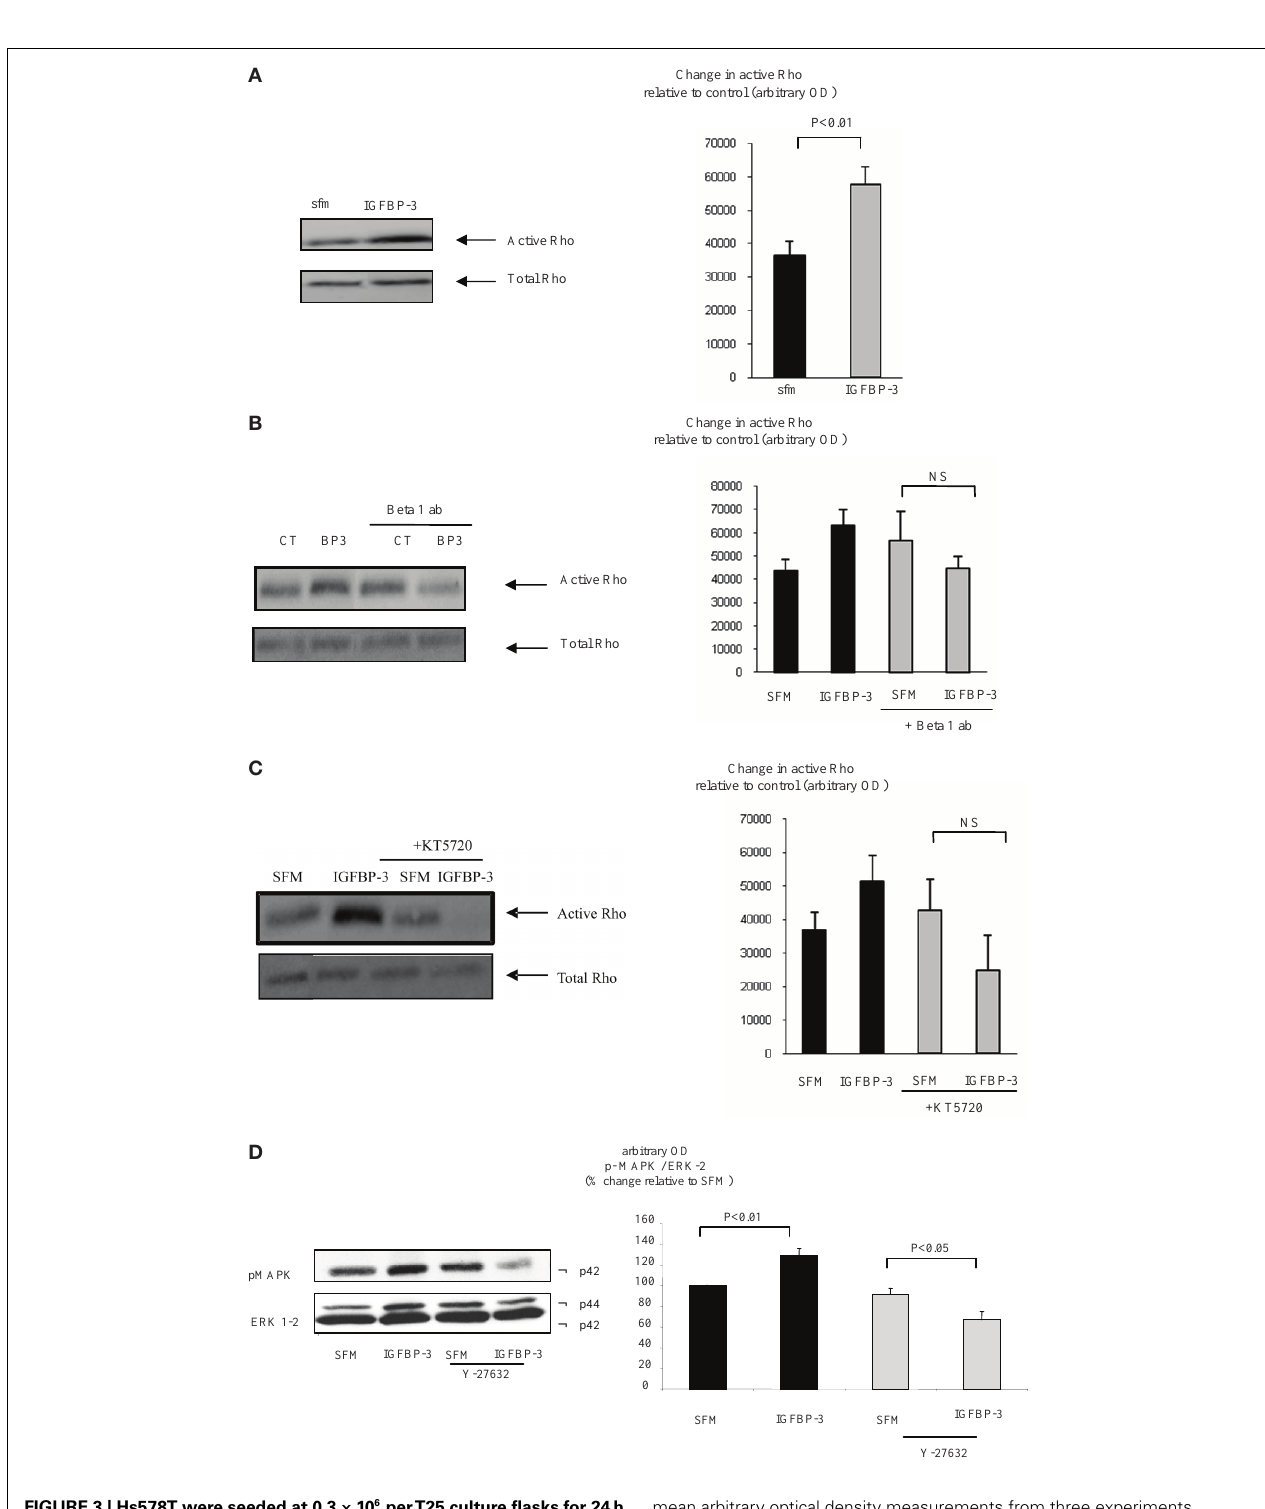
FIGURE 3 | Hs578T were seeded at 0.3 × 10 6 perT25 culture flasks for 24h after which the GM was replaced with SFM for 24h. Cells were treated (A) with IGFBP-3 (100ng/ml) for 30min or (B) with IGFBP-3 (100ng/ml) following a 30-min pre-dose with an anti-beta 1 integrin blocking antibody (200ng/ml) or (C) a PKA inhibitor KT5720 (1 μ M). Following treatment activation of Rho was assessed as described in Section “Materials and Methods.” (A–C) showWestern immunoblots (of active and total Rho and are representative of experiments repeated three times) and graphs of the